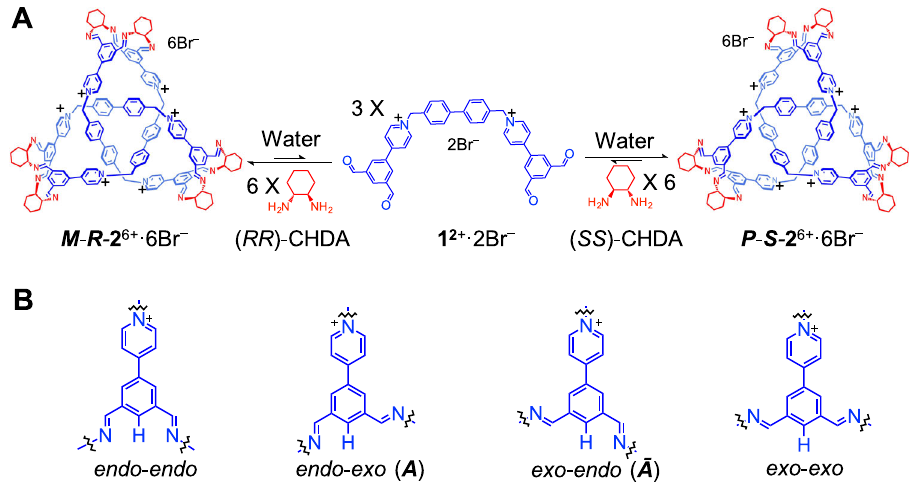
Fig. 1 Structural formulae of a pair of enantiomeric trefoil knots R -2 6 + ·6Br – , S -2 6 + ·6Br – and the corresponding precursors including 1 2 + ·2Br – and CHDA. A R - 2 6 + ·6Br – and S - 2 6 + ·6Br – were self-assembled as the predominant products, by condensing the tetraformyl precursor 1 2 + ·2Br – and a chiral bisamine namely either ( RR )-CHDA or ( SS )-CHDA in aqueous media. DFT calculation indicated that the most thermodynamically favored products of R - 2 6 + and S - 2 6 + adopt intrinsic left-handed ( M ) and right-handed ( P ) con fi gurations, respectively. B Each 1,3-bisiminophenyl unit in the 1 2 + residues of the trefoil knot M - R - 2 6 + and P - S - 2 6 + could adopt four possible conformations including endo-endo, endo-exo, exo-endo and exo-exo , de fi ned by the positions of each imino units relative to the central proton. NOESY spectrum (Fig. 2E) indicated that among these four conformations, only endo-exo and exo-endo were observed in the trefoil knots R - 2 6 + and S - 2 6 + . Also, because the corresponding 1 H NMR spectrum of either M - R - 2 6 + or P - S - 2 6 + only show a set of resonances, it is reasonable to propose that within the framework of each trefoil knot either M - R - 2 6 + or P - S - 2 6 + , all of the six 1,3-bisiminophenyl units adopt the same conformation. DFT calculation indicated that the most thermodynamically favored conformations of M - R - 2 6 + and P - S - 2 6 + are ( endo - exo ) 6 and ( exo - endo ) 6 , which are denoted as A and ᾹᾹ ,